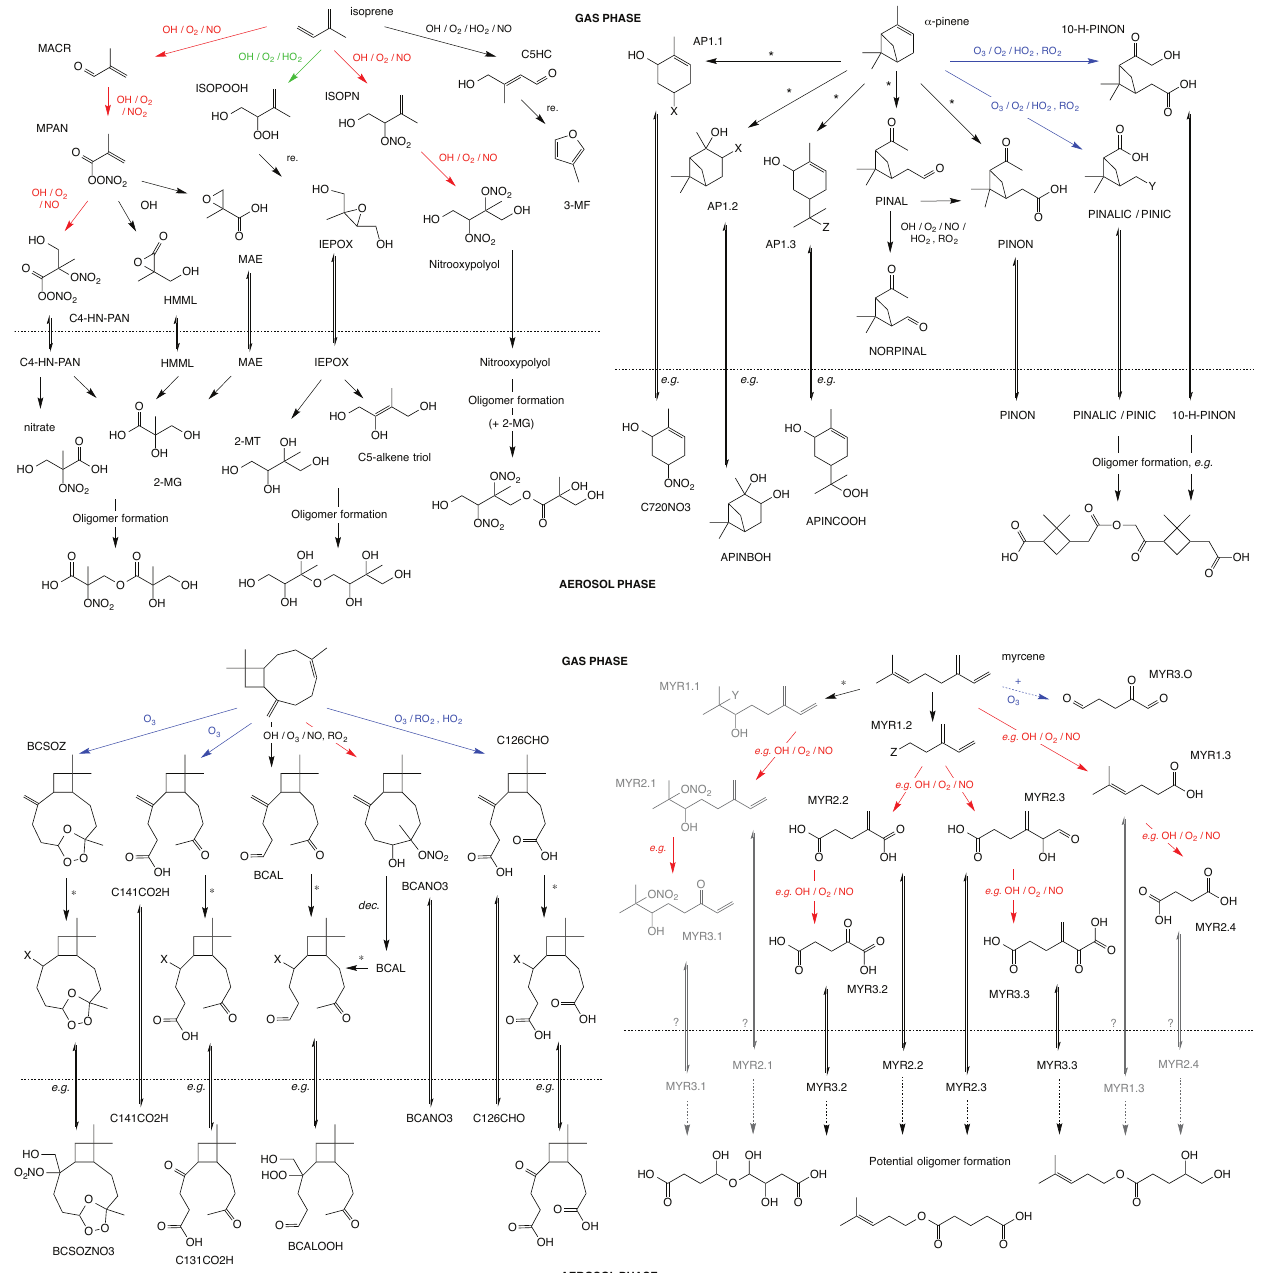
Figure 9. Simplified schematic illustrating some of the important mechanistic pathways in the gas-phase oxidation of isoprene, α -pinene, β -caryophyllene and myrcene, and the associated mass transfer to the particle phase (obtained from the current literature; see text, Sect. 5 for references). Red arrows and text represent “high NO x ” pathways, green arrows and text – “low NO x ” pathways, blue arrows and text – ozonolysis reactions, grey arrow and text – speculative and dashed arrows – multiple steps. * represents multiple photooxidative routes initiated by reaction with OH (i.e. involving the reactants – OH, O 2 , NO, HO 2 and/or RO 2 ), leading to structurally similar products containing different functional groups. α -pinene mechanism – X = OH, = O, OOH or ONO 2 ; Y = CHO or C(O)OH; Z = OH, OOH or ONO 2 . β -caryophyllene mechanism – X = CH 2 OH(OH), CH 2 OH(OOH), CH 2 OH(ONO 2 ) or = O. Myrcene mechanism – Y = OOH or ONO 2 ; Z = CHO or